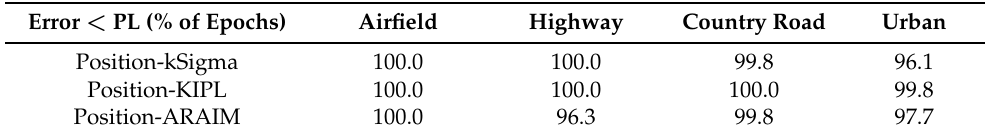
Table 7. Percentage of epochs in which the error in the position solution of the sensor data fusion algorithm is bounded by the implemented protection levels. Error < PL (% of Epochs)